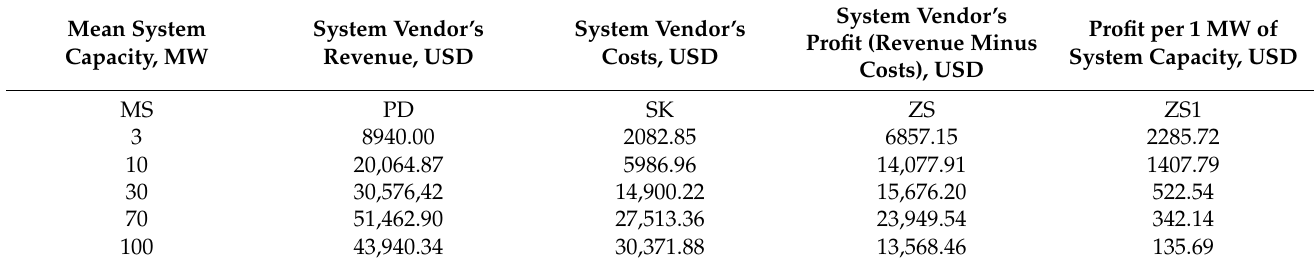
Table 8. The system vendor’s profit after subtracting all